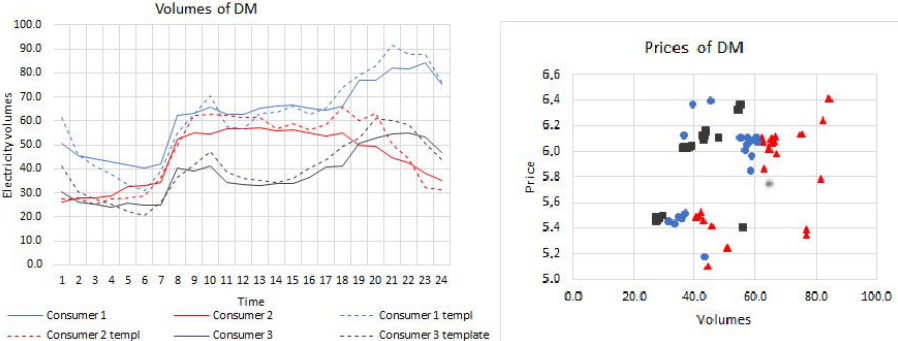
Figure 13. Chart of the load and prices before and after applying the optimal mechanism (“Opt mechanism”).